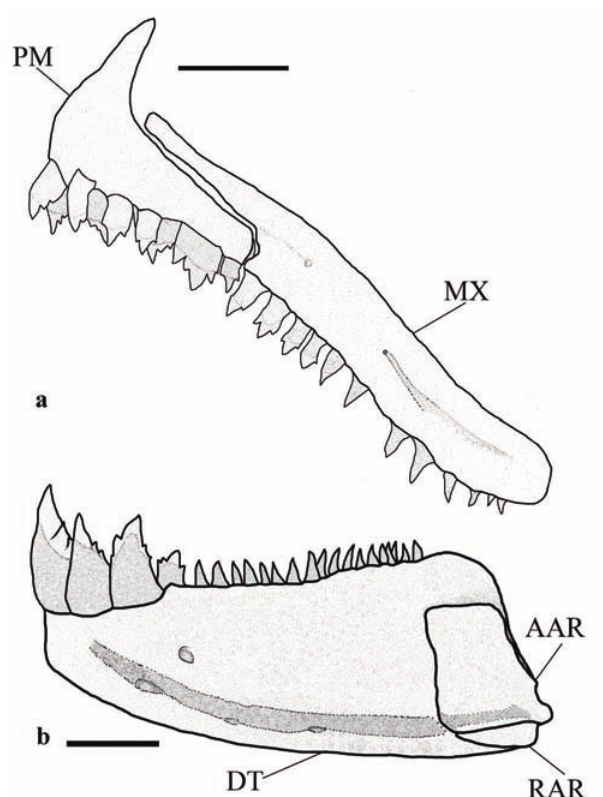
Fig. 2. Chrysobrycon yoliae , CI-FML 5882, paratype male, 44.8 mm SL. Lateral view of jaws: ( a ) Premaxilla (PM) and maxilla (MX), left side. ( b ) Dentary (DT), anguloarticular (AAR) and retroarticular bones (RAR), left side. Scale bar = 1